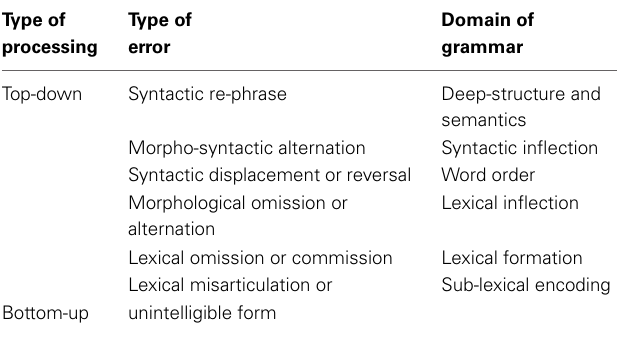
Table 6 | Modeling the correlation of error type to the layering of